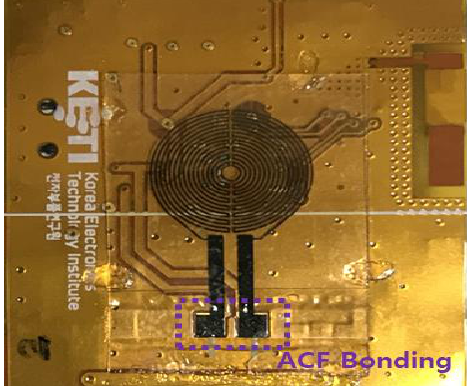
Figure 3. Sensor and circuit bonding (anisotropic conductive film (ACF) bonding).